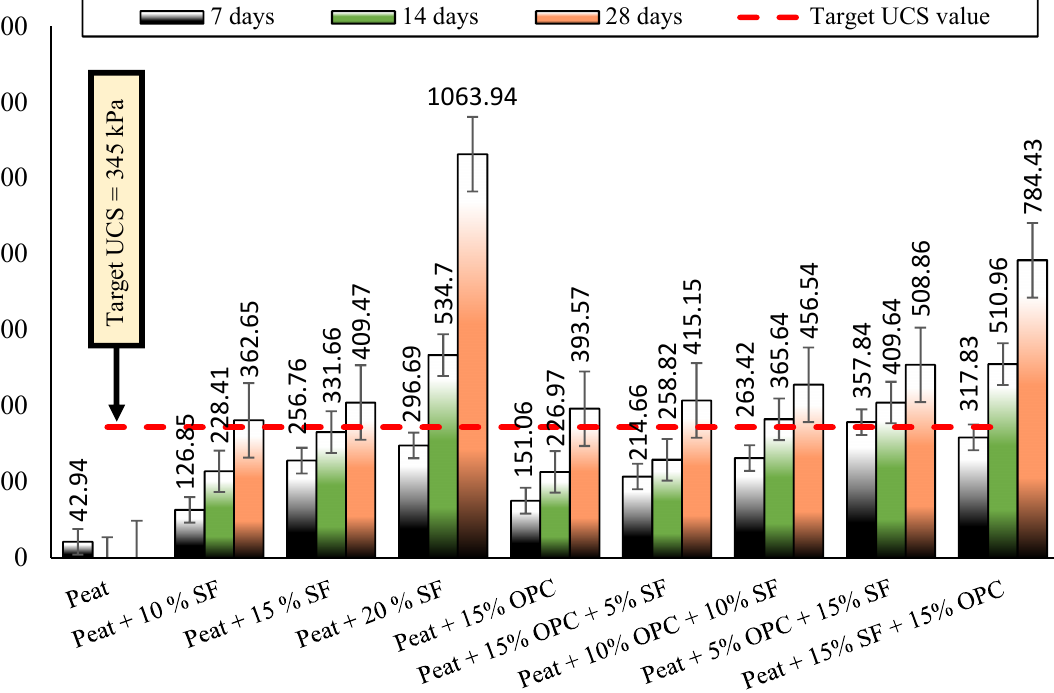
Figure 7. Strength development index (SDI) of all mixes after 7, 14, and 28 days of curing. 3.3.3. Binder’s Effect on the Failure Modes The presence of fibers and partially decomposed vegetation induces structural ani- sotropy in peat, thus affecting the compression modes of failure [42]. The failure modes of the parent Teluk Intan peat and stabilized peat are presented in Figure 8. It can be ob- served that the failure pattern changed with the stabilization of peat. Moreover, the failure behavior changed with binder dosages due to changes in density [43].